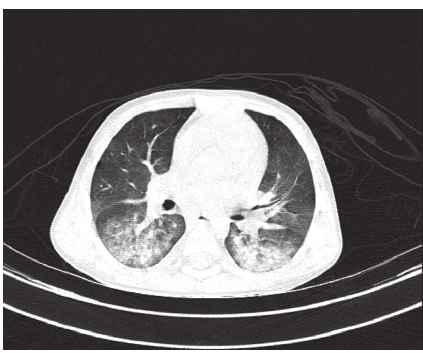
Figure 5: A 9-year-old case with the proven COVID-19 PCR test and bilateral lower lobes GGO.